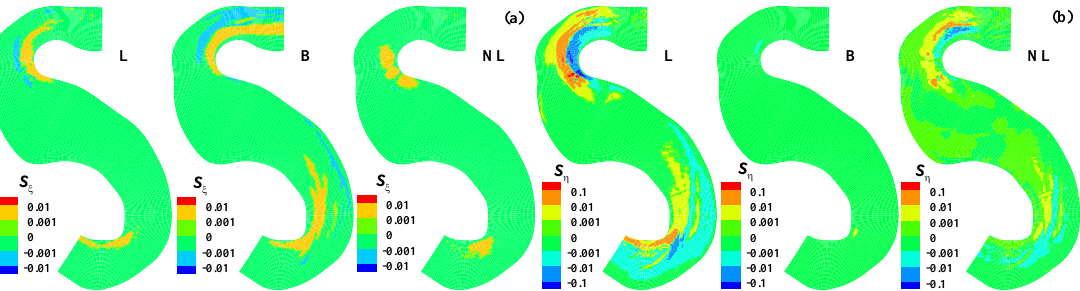
Figure 10. Correction terms ( a ) S ξ and ( b ) S η distributions of the L, B, and NL models along the channel.